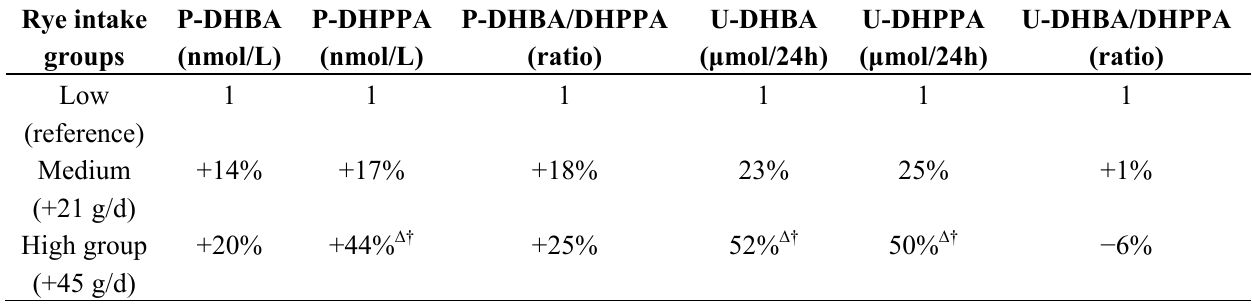
Table 3. Responsiveness of urinary and plasma alkylresorcinol metabolites to rye